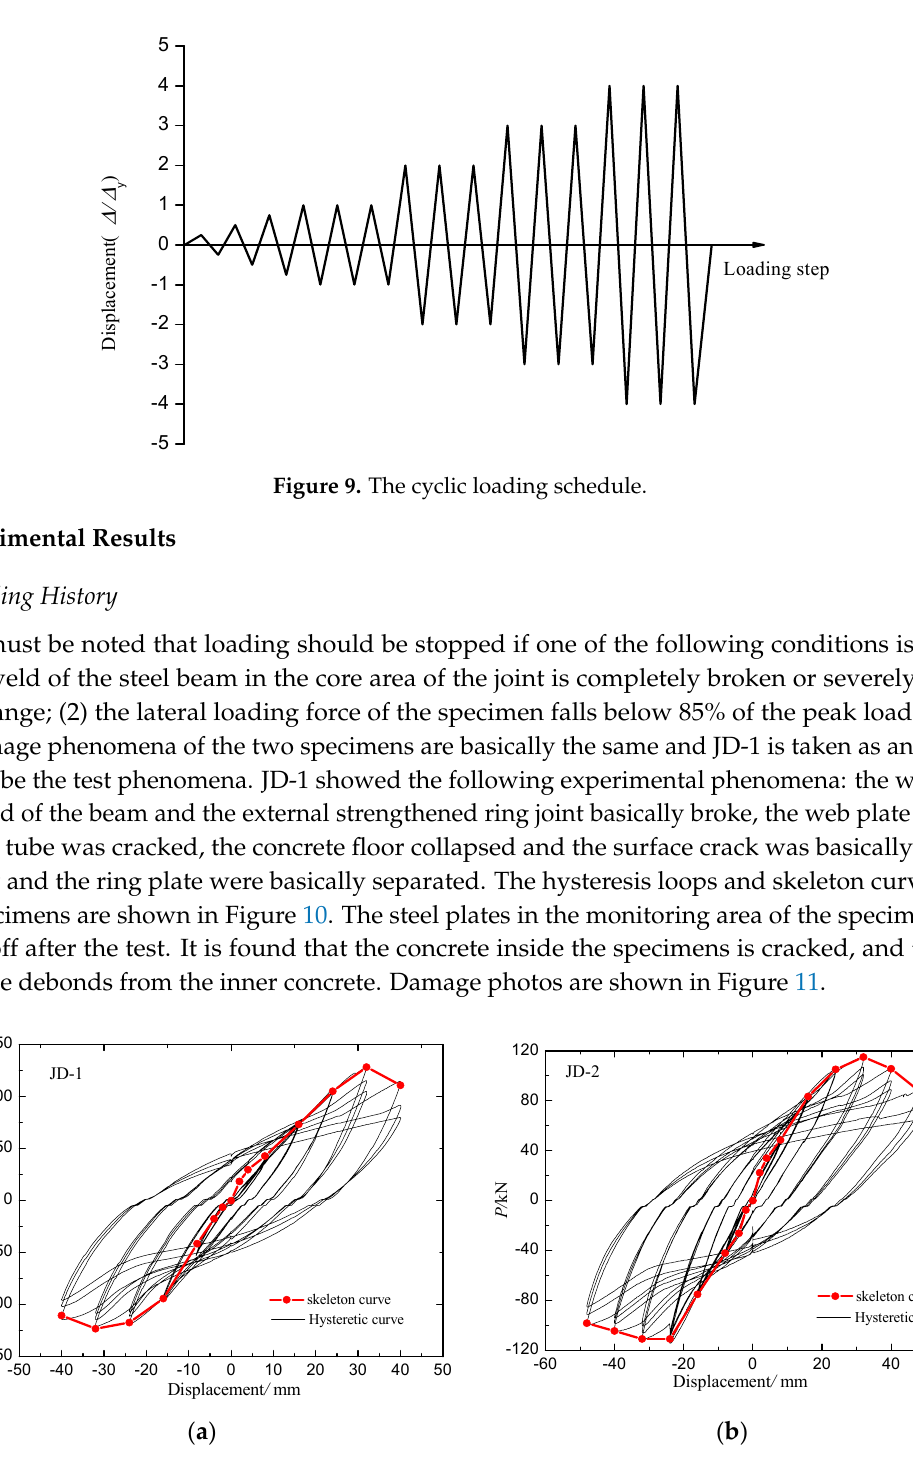
Figure 10. Hysteresis loops and skeleton curves of joint Specimens. ( a ) Specimen JD-1; ( b ) Specimen JD-2.